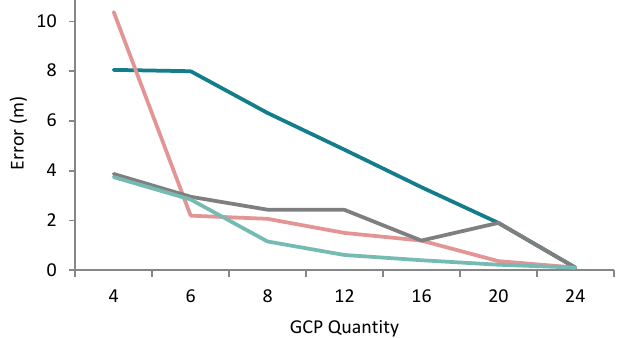
D Figure 7. Surface checkpoint error of the four configuration